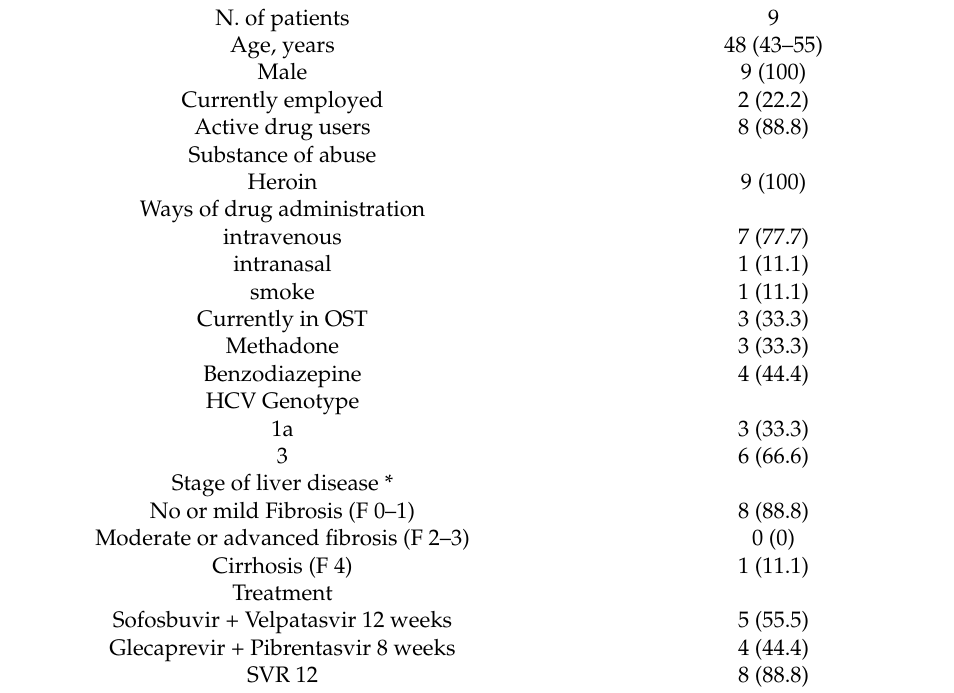
Table 2. Characteristics of PWUDs with poor adherence to treatment